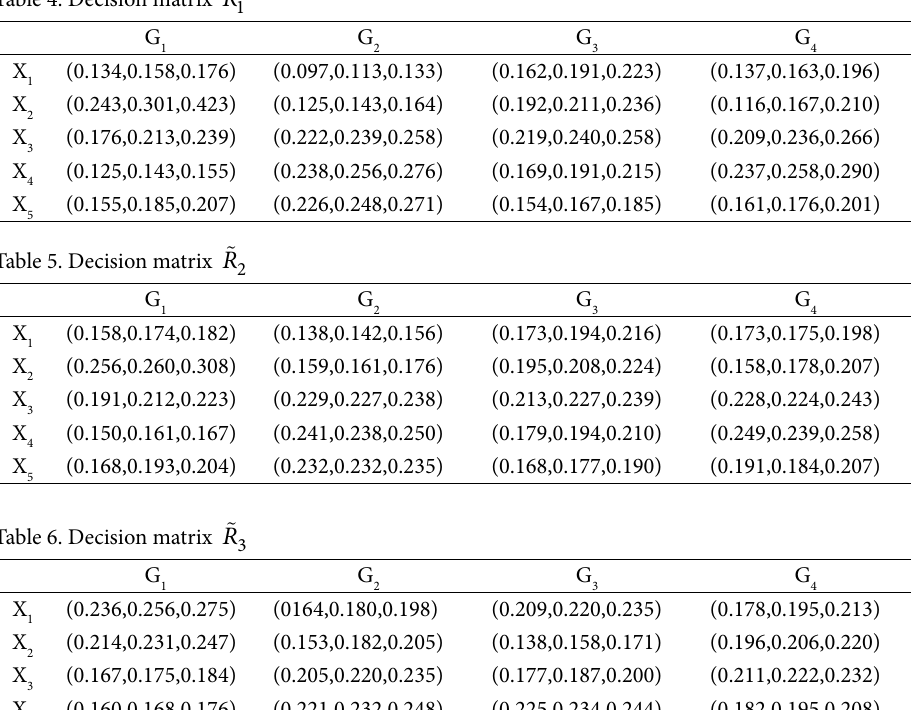
Table 4. Decision matrix 1 R 